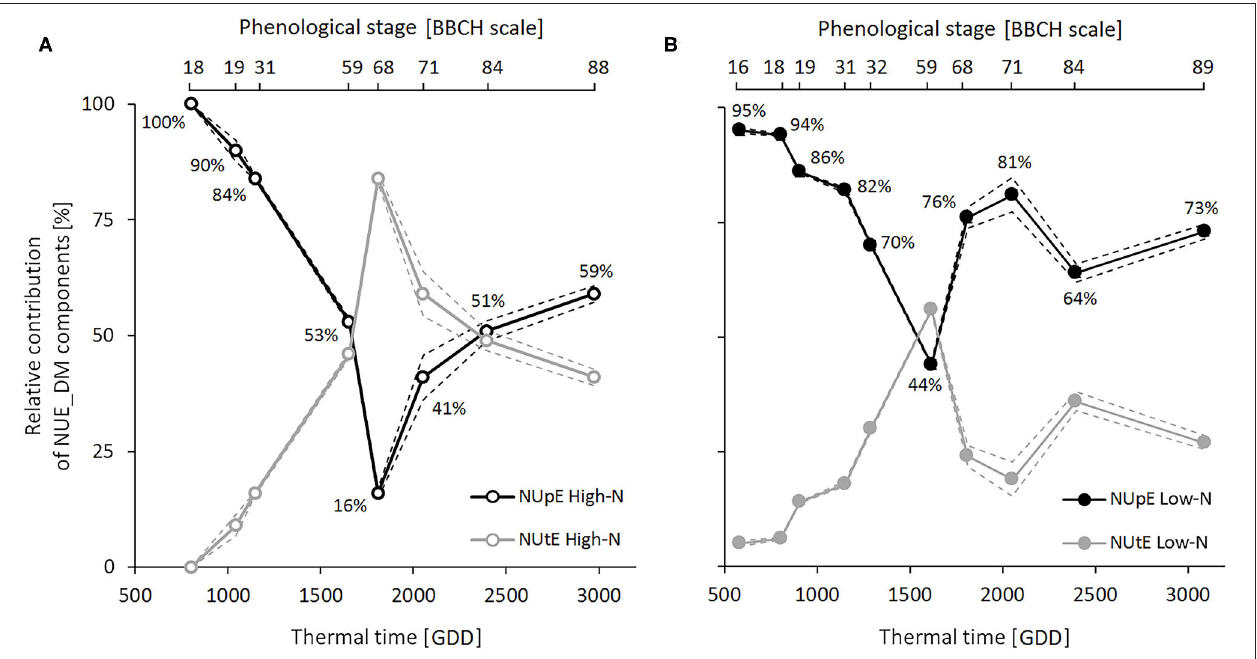
FIGURE 3 | Contribution dynamics of N Uptake Efficiency (NUpE) and N Utilization Efficiency (NUtE) to variations in dry-matter-based N Use Efficiency (NUE_DM) throughout the crop cycle under high-N (A) and low-N (B) conditions. Relative contributions were calculated by pooling samples of all genotypes from LR15, GR15, and GR18 experiments ( n = 6–37 for the low N-condition and n = 6–30 for the high-N condition at each sampling date). Black and gray symbols correspond to NUpE and NUtE, respectively. Dashed lines depict 95% confidence intervals. The percentage values correspond to the NUpE contributions to NUE_DM.